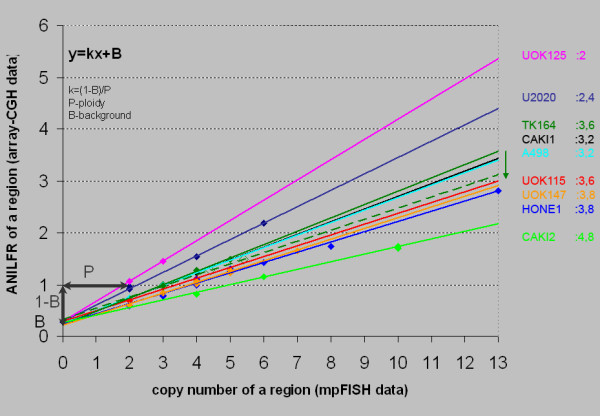
Correlation between ANILFR (Average Normalized Inter-Locus Fluorescence Ratio) value identified by array-CGH and copy number determined by mpFISH. X-axis: copy number of chr3 regions (R1, R2...) identified by interphase and/or metaphase mpFISH (see "Copy nr FISH" in table 1). Y-axis: ANILFR value for the same regions (see ANILFR in Table 1). As example for UOK125 cell line: Region R1, has an ANILFR of 1.07 (Y-axis value), which corresponds to 2 copies of this region on chr3 (X- axis value). (see Figure 5C and Table 1). These (x, y) coordinates define the first data point (pink romb) for the UOK125 trend line. The second data point corresponds to R2 with ANILFR of 1.46 (Y-axis value), and with a copy number of 3 (X- axis value). Each cell line has a number of data points (rombs of respective colour) corresponding to the number of chr3 region of different copy number (Table 1 – Region). Trend lines for each cell line were calculated and drawn. The interception of trend lines on Y-axis indicates the intensity of the background fluorescence "B" (corresponding to 0 copies, homozygous deletion region in U2020, ANILFR of 0.28). The slope of the trend lines reflects ploidy level. At the right from the graph, the ploidy number obtained from chromosome counts is shown for the respective cell lines ("Ploidy C" on Table 1). See other explanations in the text.